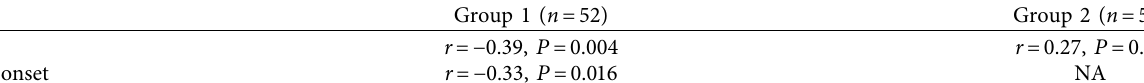
Table 3: The correlations of serum IL-17A levels with ages and age of onset in the study groups.